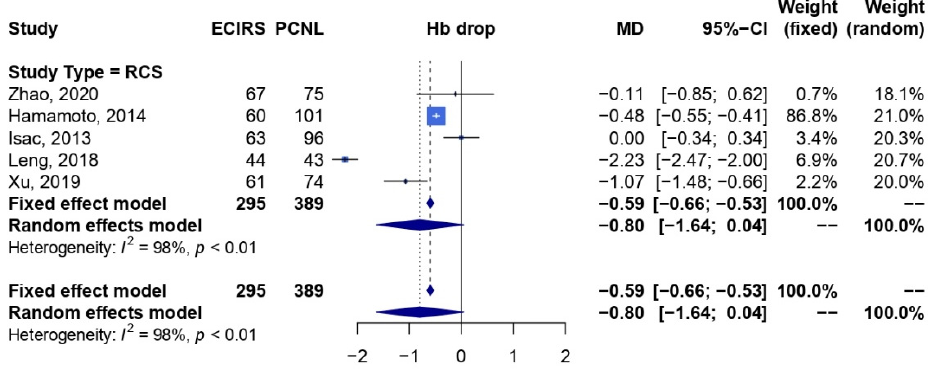
Figure A15. Subgroup analysis of outcome regarding hemoglobin drop. (RCS: [18,19,21–23]).